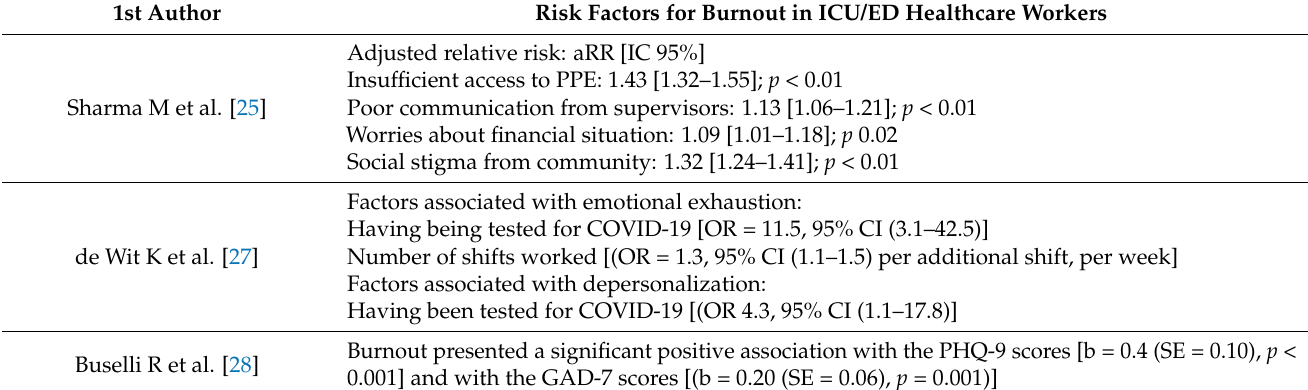
Table 3. Systematic review on burnout among professionals working in intensive care units and emergency departments: selected